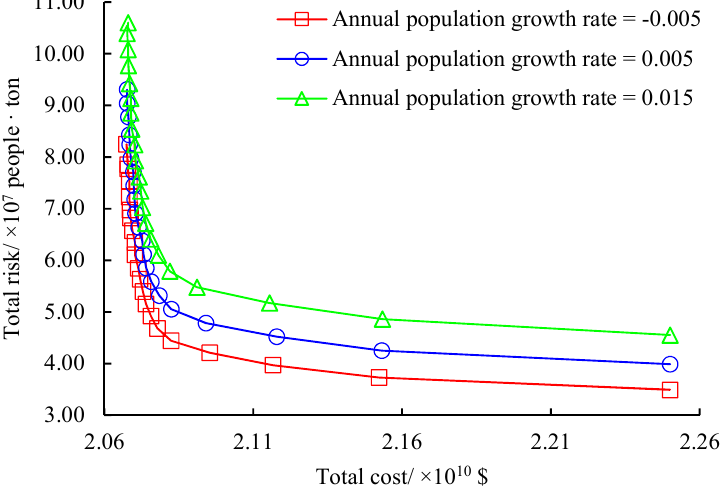
Figure 10. Effects of annual population growth rate.